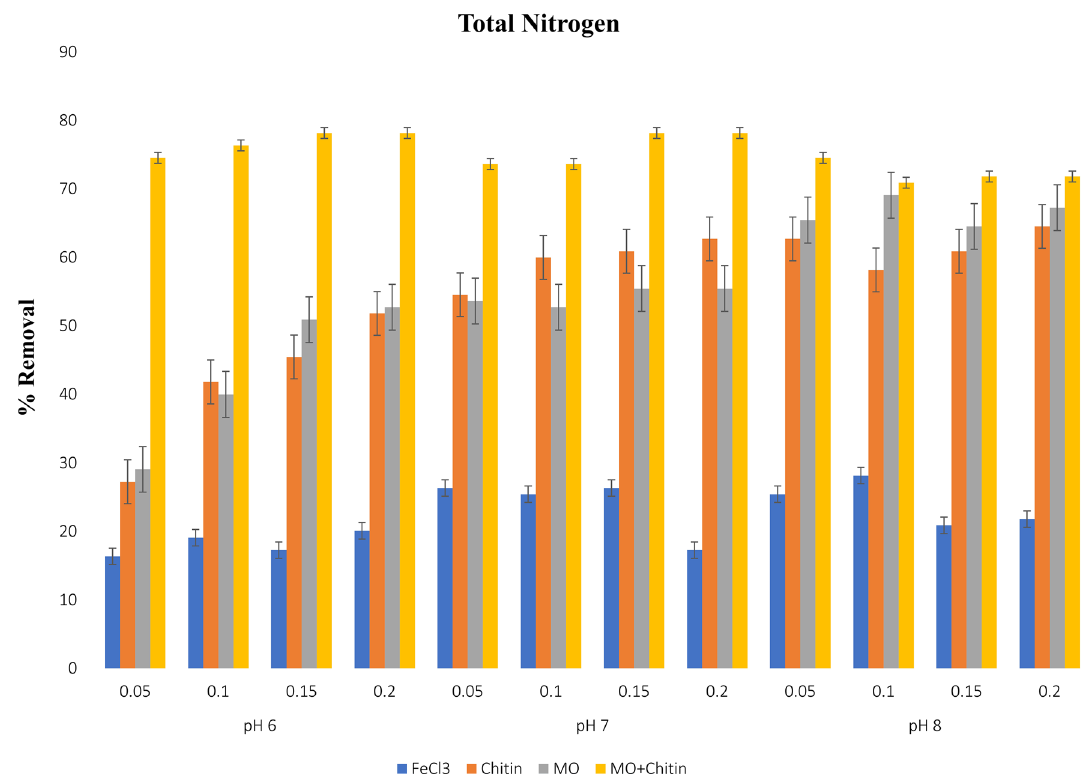
Fig. 7 Total nitrogen reduction by the